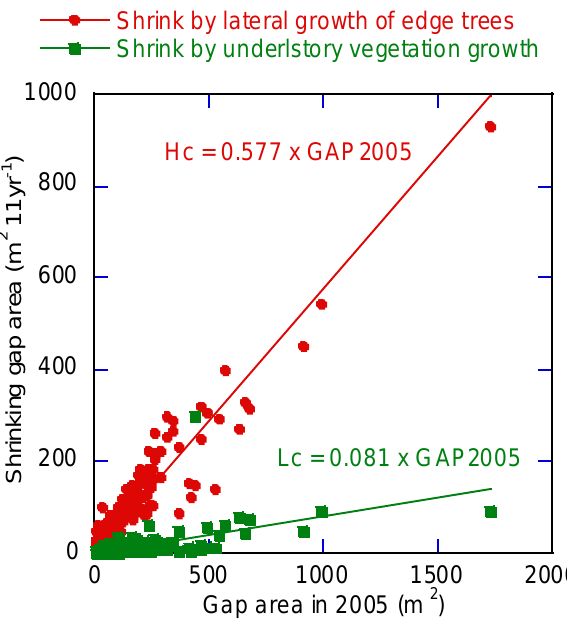
Figure 9. Relationship between the initial gap area in 2005 and closure or reduction of gap area by 2016. The causes of gap closure are lateral growth of surrounding trees and height increase of understory vegetation. Lateral growth of surrounding trees affected gap closure more strongly than height increase of understory vegetation. The gap area reduction or closure is proportional to the initial gap area.